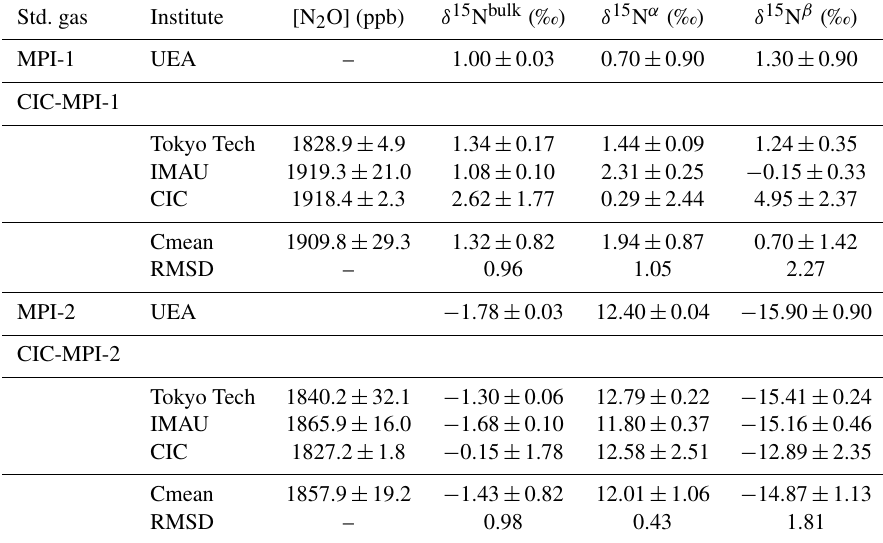
Table 1. Measurements of standard gas CIC-MPI-1 and CIC-MPI-2, and of diluted MPI-1 and MPI-2 gases. Measurements were measured at the four respective institutes. The combined mean values (Cmean) and standard deviations are calculated from measurements performed at Tokyo Tech, IMAU, and CIC. The root-mean-square deviations (RMSDs) are calculated against the original University of East Anglia (UEA)